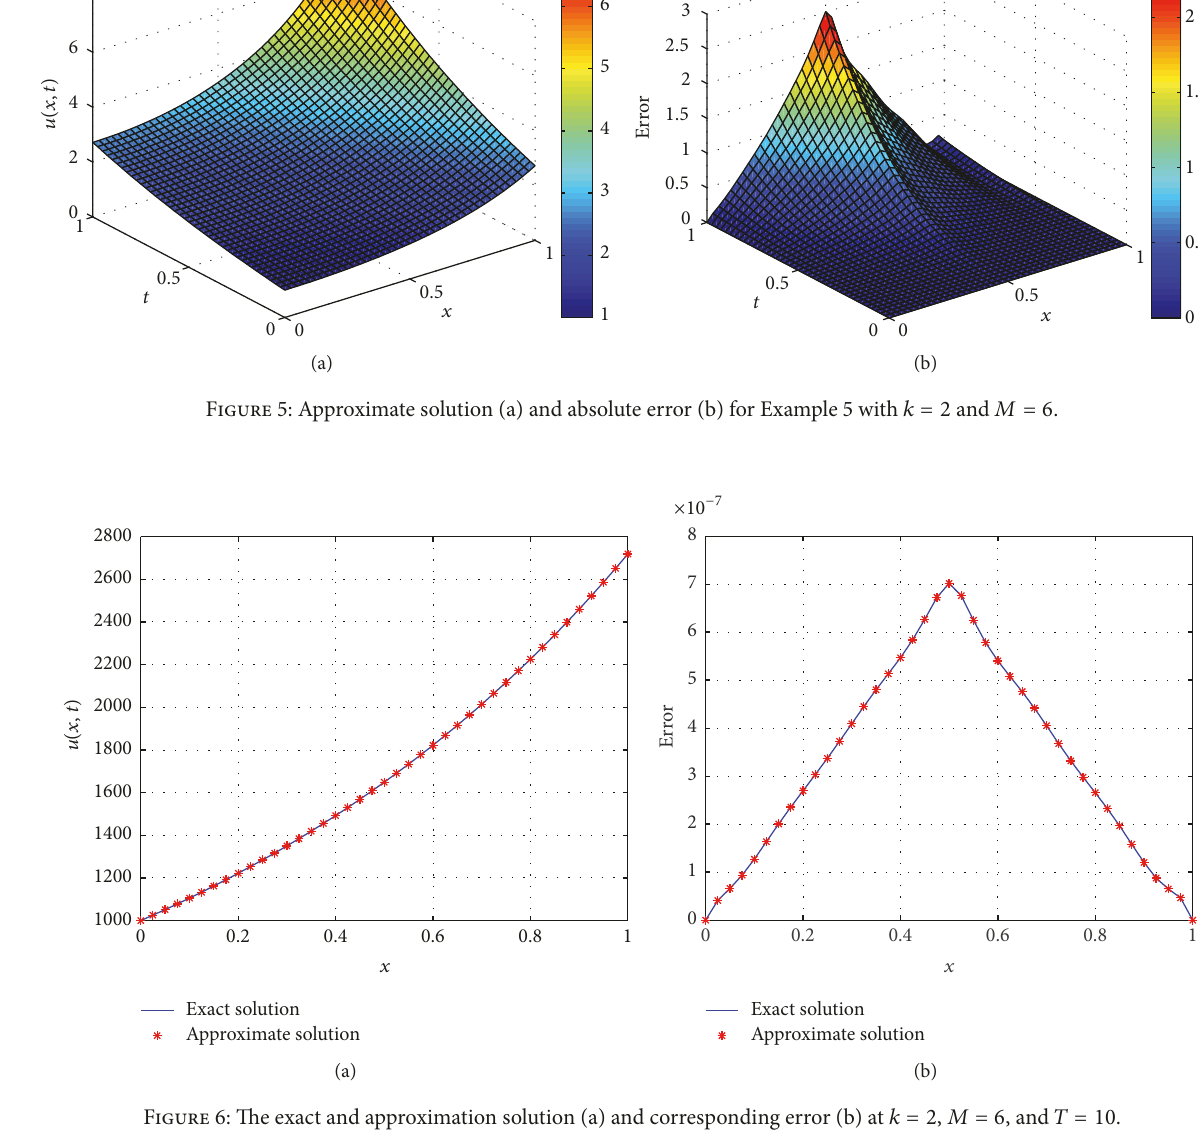
close to the exact ones for all chosen 𝛼 with 1 < 𝛼 ≤ 2 . It